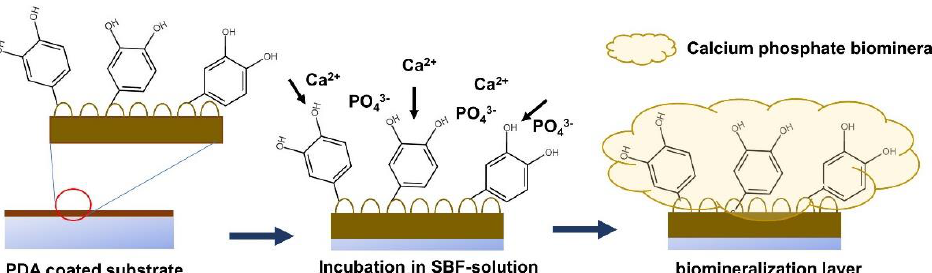
Figure 2. A schematic illustrating the procedure of biomineral deposition on a PDA-coated surface. Simulated body fluid (SBF) at various concentrations can be used as a source of Ca 2+